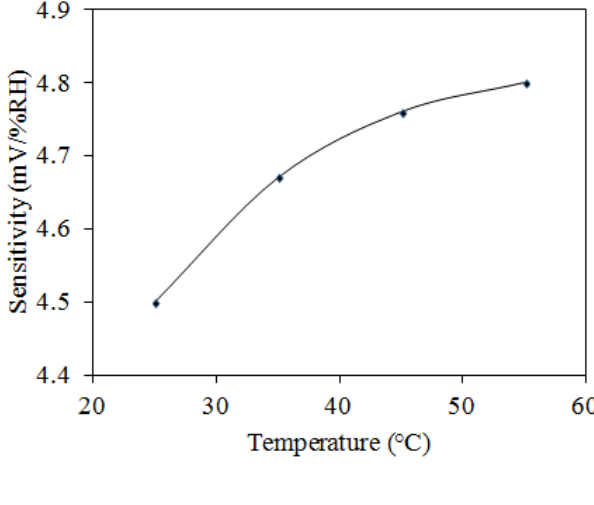
Figure 13. Relationship between sensitivity and temperature for the humidity